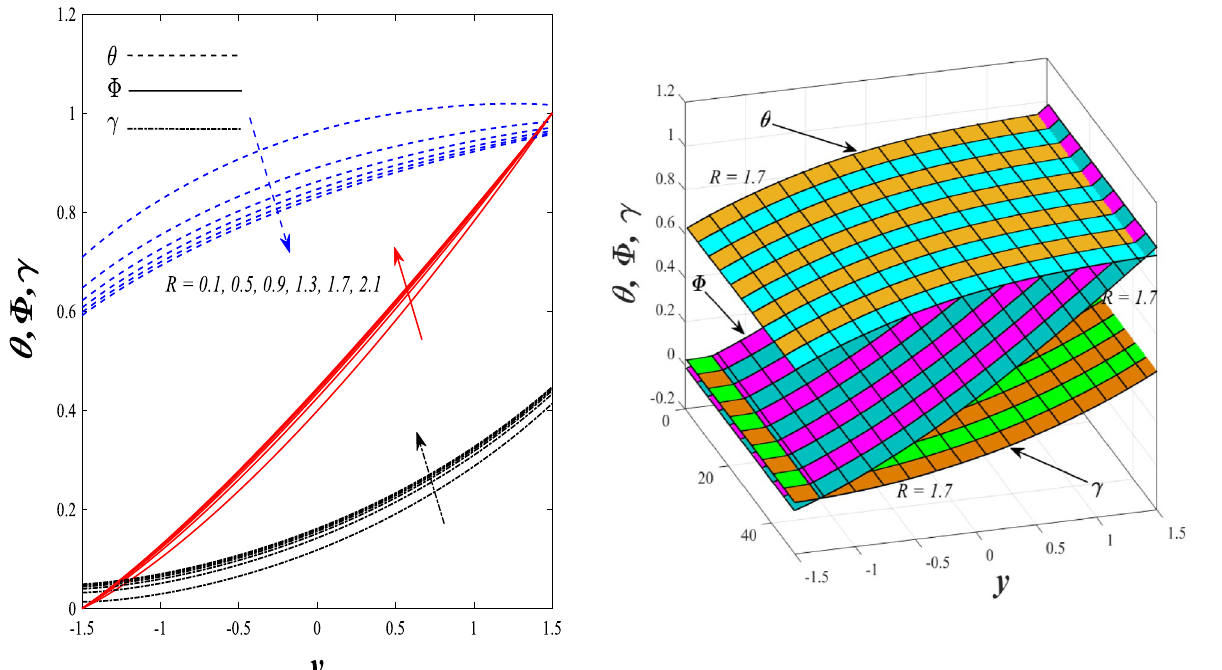
Figure 9. Effect of non-linear thermal radiation parameter R on the distributions of both temperature, solutal concentration and nanoparticles volume fraction 2D and 3D.